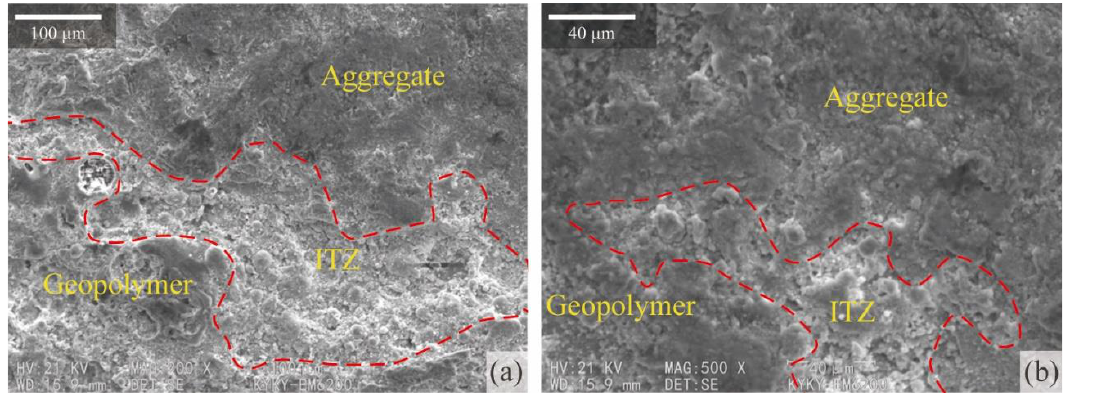
Figure 6. ITZ images of slag/fly-ash-based geopolymer-stabilized macadam. ( a ) 100 μm. ( b ) 40 μm .